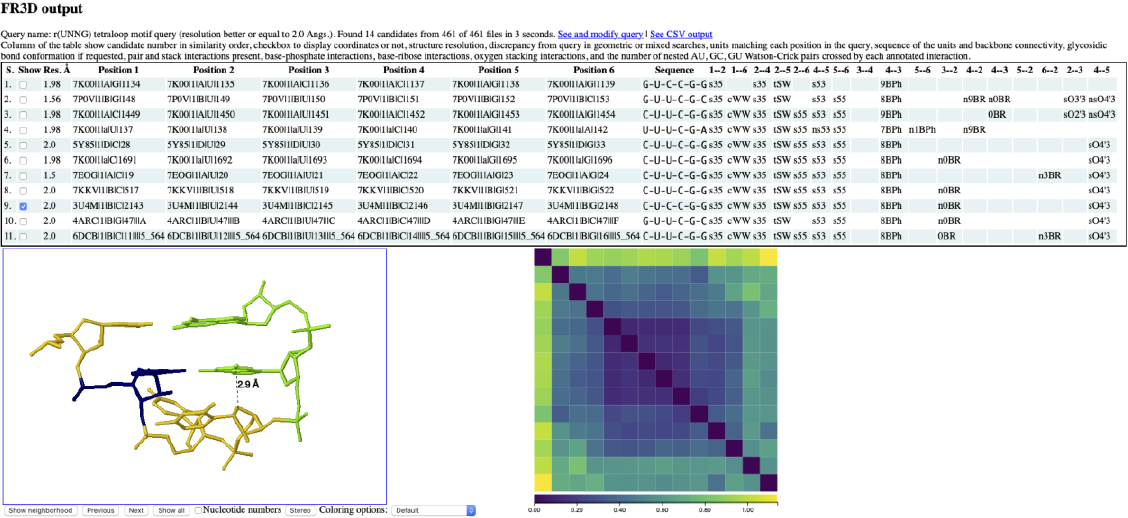
Figure 5. A WebFR3D symbolic query for r(nU 2 NNGn) Z-turn motifs. ( Top ) Panel showing the query constraints. ( Bottom ) Partial view of the WebFR3D result panel showing the first 12 instances, the tetraloop of the 3U4M structure, and a heat map showing the 14 by 14 matrix of mutual geometric discrepancies between the instances. The 2.9 Å lp…π contact between the ribose O 4′ and the guanine C2 atom is visualized by a dashed line. This search shows that imposing a trans- Sugar…Watson -Crick (tSW) U 2 •G 5 pair (yellow box) and nucleotides that are consecutive in the (n, n + 1) or ( 5′ to 3′) direction (“next” in blue boxes) is sufficient to retrieve fourteen r(nUNNGn) folds with the Z-turn characteristics discussed in Section 3.4 and present in the 3.230 representative set of structures [67]. However, a more stringent query is needed to discard problematic structures from this and lower resolution ensembles (Figure S3). Use the following link to retrieve the results of this search: http://rna.bgsu.edu/webfr3d/Results/62c6809102051/62c6809102051.html (accessed on 7 July 2022).